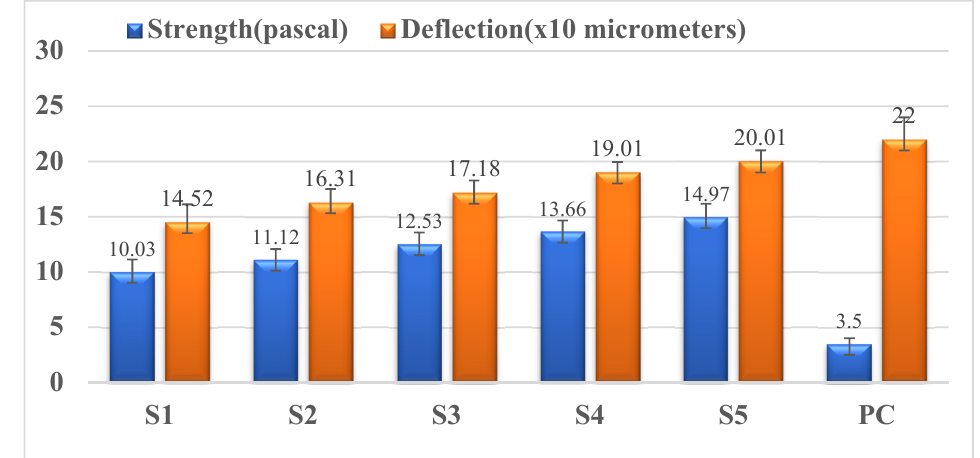
Figure 5. Variation of strength and deflection for different samples .